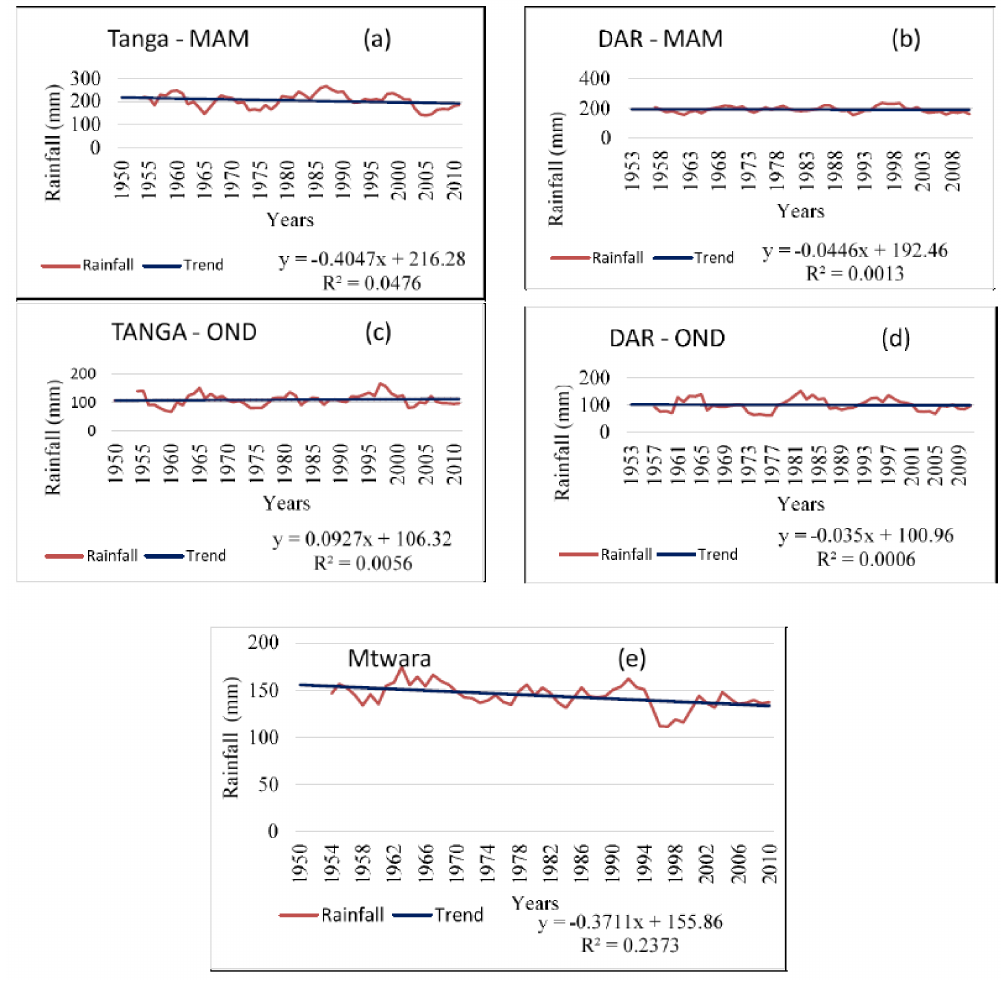
Figure 3. Moving average rainfall for the three Tanzania coastal stations (Tanga, Dar es Salaam and Mtwara). Tanga and Dar es Salaam experiences two rainfall seasons (Masika and Vuli), Mtwara observes one rainfall season. Tanga ( a ) and Dar es Salaam ( b ) represent the Masika (MAM) season. Tanga ( c ) and Dar es Salaam ( d ) represent Vuli (OND) season. Mtwara rainfall season ( e